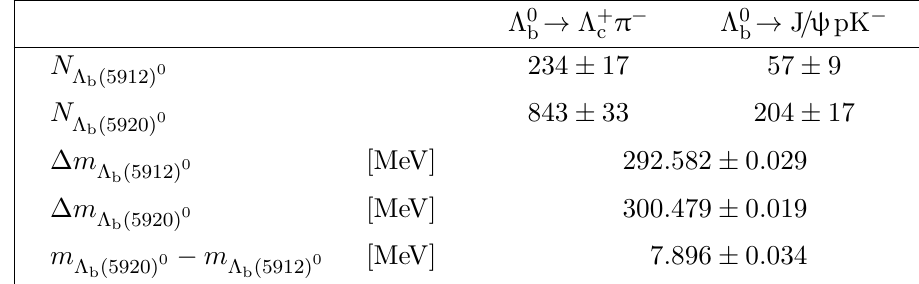
Table 3 . Results of the combined (cid:12)t to the low-mass (cid:3) 0